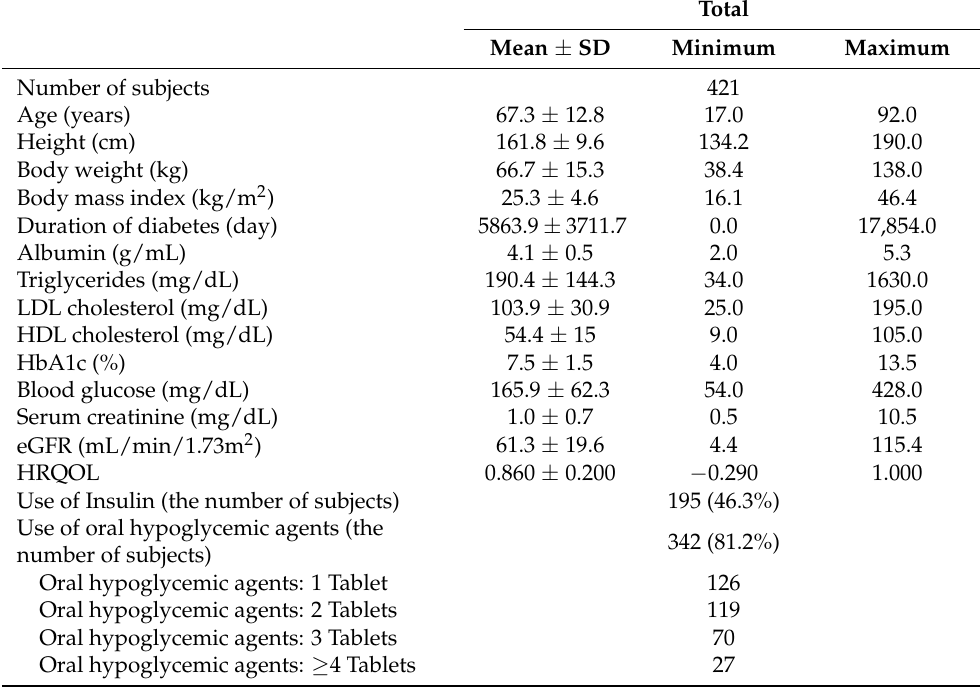
Table 1. Clinical profiles of patients with type 2 diabetes mellitus enrolled in this study.